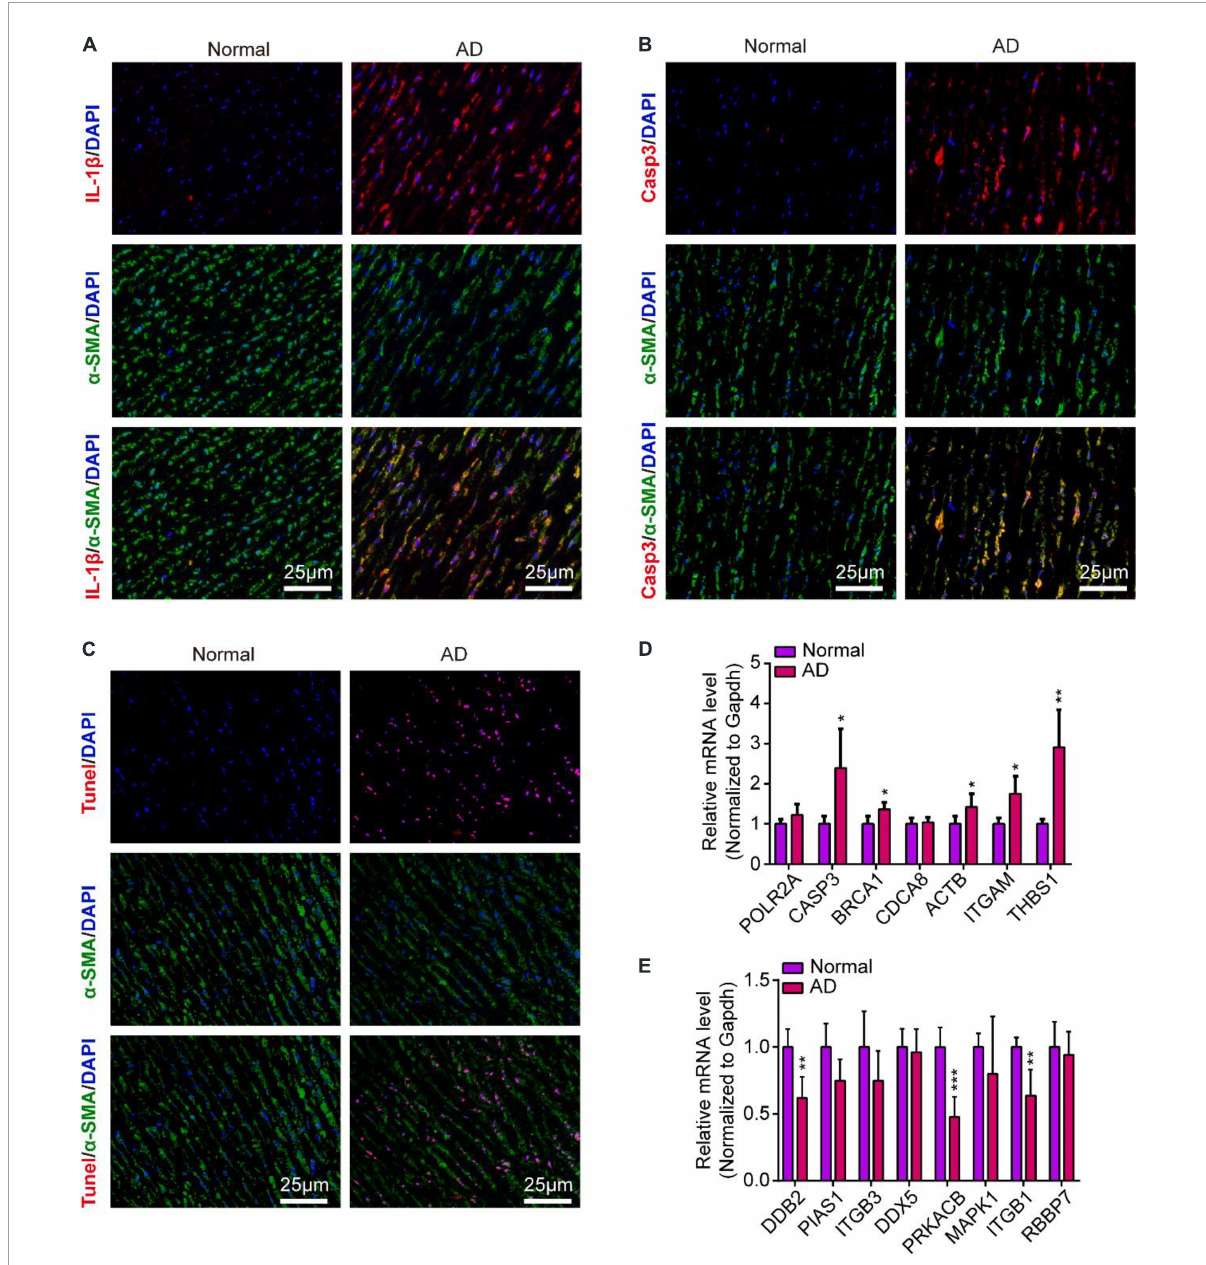
FIGURE10 Inflammation and apoptosis were widely found in human aortic dissection and the validation of hub genes in human aortic dissection. (A–C) Representative images of immunofluorescence staining demonstrate Il-1 β (A) , Casp3 (B) expression and Tunel positive cells (C) in human aortic tissues of aortic dissection (AD) and normal controls. Scale bar = 25 µ m. (D,E) Quantitative real-time polymerase chain reaction (qRT-PCR) analysis show the expression of hub genes in human aortic tissues of AD and normal controls, including (D) upregulated hub genes and (E) downregulated hub genes. GAPDH was used as internal control; For normal group, n = 4, for AD group, n = 6; * P < 0.05, ** P < 0.01, *** P <